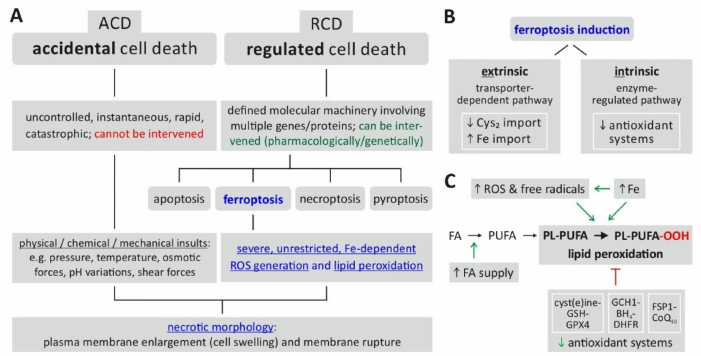
Figure 1. Ferroptosis—classification, characteristics, induction. ( A ) Ferroptosis is classified as a form of regulated cell death characterized by severe, uncontrolled lipid peroxidation and loss of cell membrane integrity. ( B ) The prerequisites for induction of ferroptosis include the generation of reactive oxygen species (ROS) fueled by an increase of intracellular iron (Fe), which cause oxidation of membrane lipids. The changes are enabled (facilitated) by a reduced activity of cellular antioxidant defense mechanisms. ( C ) Ferroptosis induction is further classified into an extrinsic or intrinsic pathway. Abbreviations: ACD = accidental cell death, BH4 = tetrahydrobiopterin, CoQ10 = coenzyme Q10, Cys2 = cystine, DHFR = dihydrofolate reductase, FA = fatty acid, FSP1 = ferroptosis suppressor protein 1, GCH1 = GTP cyclohydrolase 1, GPX4 = glutathione peroxidase 4, GSH = glutathione (re- duced), PL-PUFA = PUFA-containing phospholipid, PL-PUFA-OOH = phospholipid hydroperoxide, PUFA = polyunsaturated fatty acid, RCD = regulated cell death, ROS = reactive oxygen species. Based on: